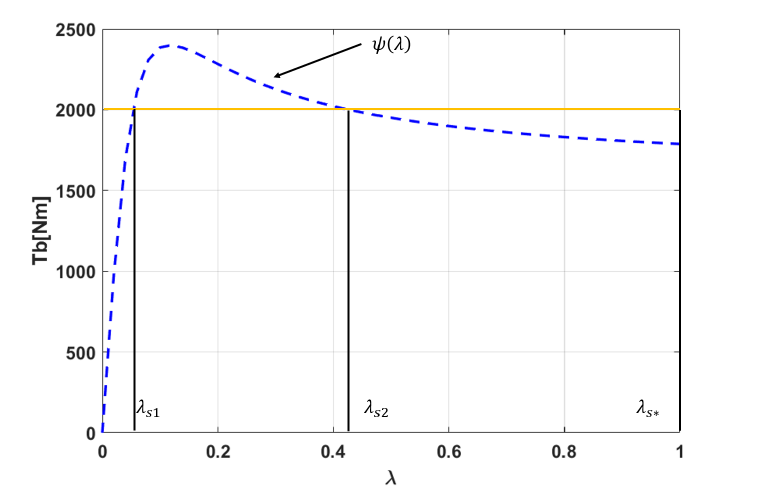
Figure 4. Equilibrium points for aircraft anti-skid braking